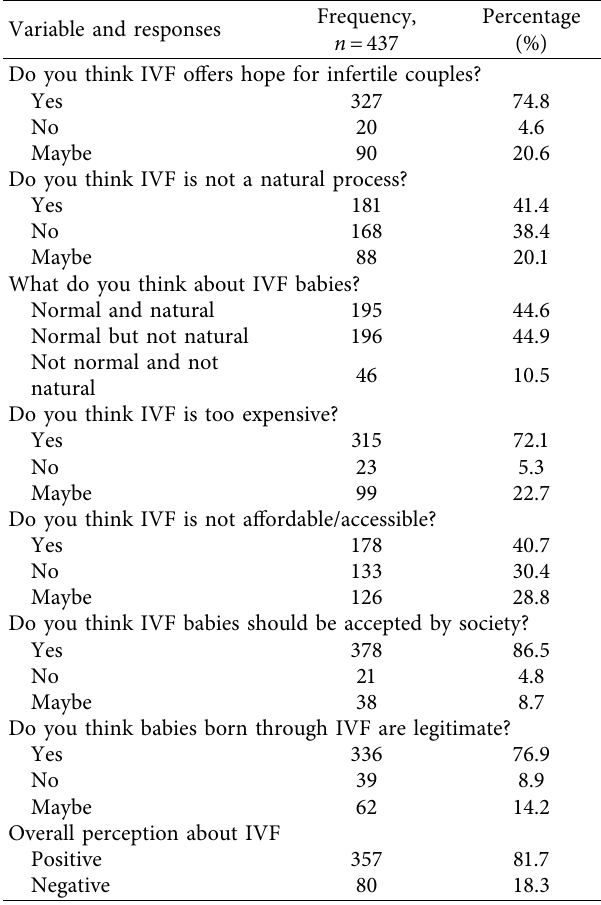
Table 2: Respondents’ perceptions and misperceptions of IVF